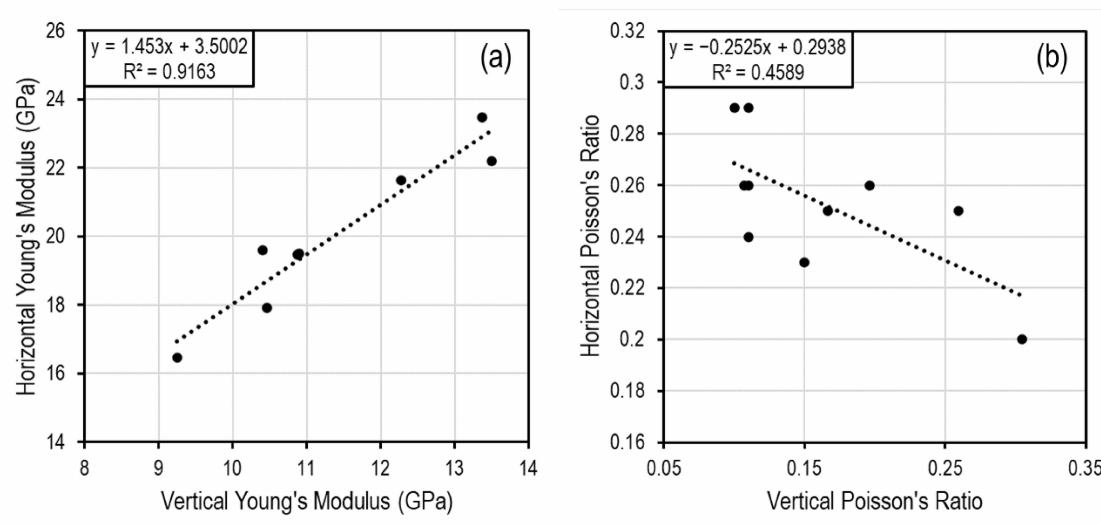
Figure 16. ( a ) Dynamic young’s modulus and ( b ) Poisson’s ratio anisotropy